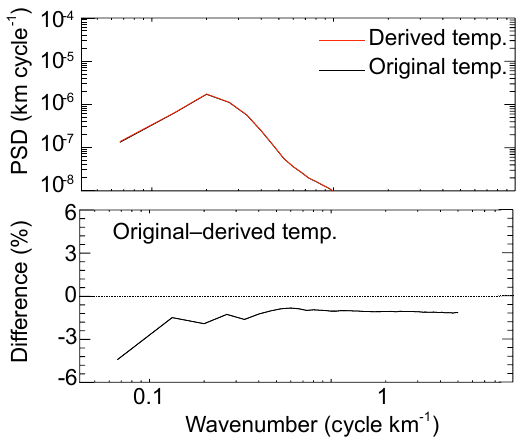
Figure 3. Power spectra density of normalized temperature pertur- bations and their differences for GPS RO and derived temperature